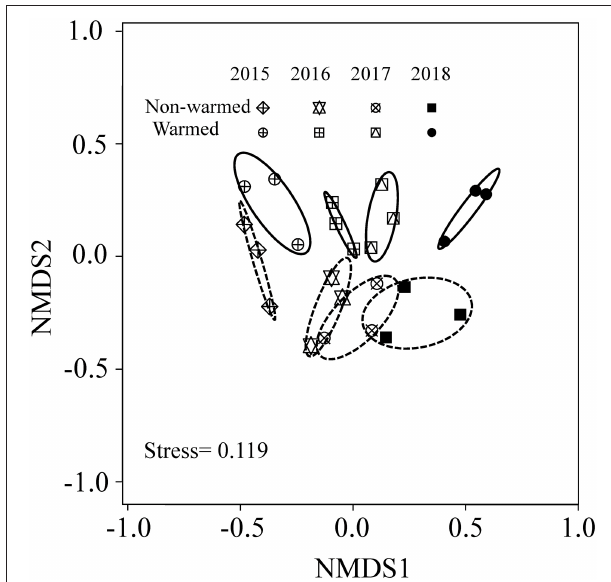
FIGURE 3 | Results of non-metric multidimensional scaling (NMDS) showing community dissimilarity between non-warmed and warmed chambers and years (2015–2018). Dissimilarity (Bray-Curtis) was estimated using the relative abundance of each